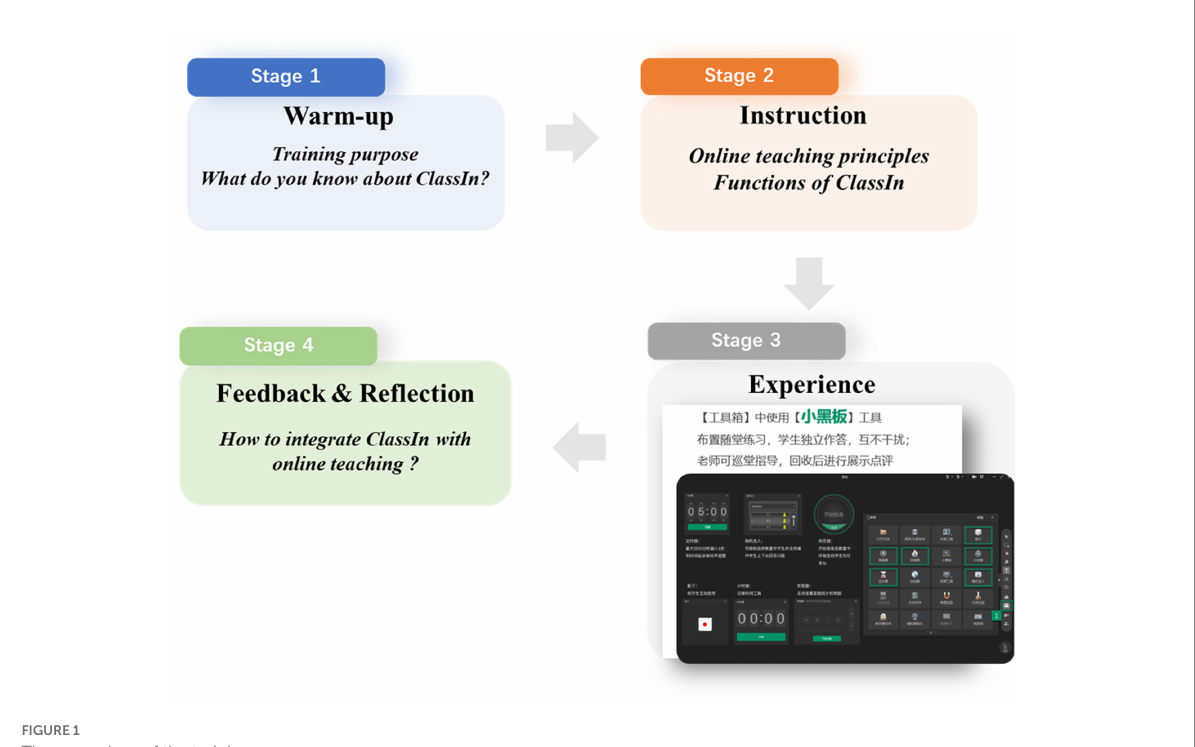
FIGURE 1 The procedure of the training